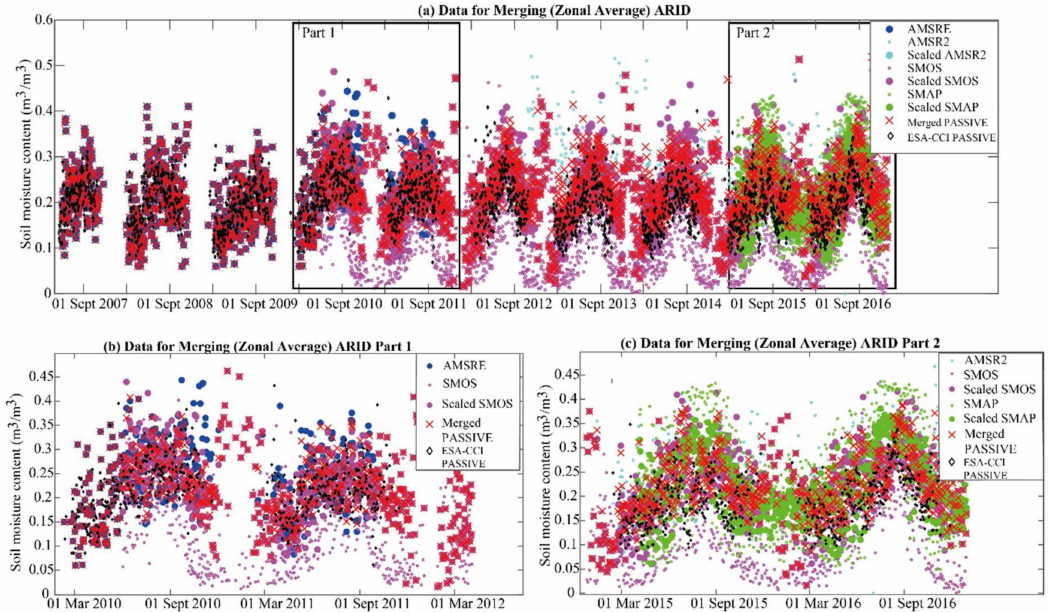
Figure 3. Time Series of Data Involved in Data Merging Procedure ( a ) Original Satellites Data, Scaled Data used for Merging, European Space Agency Climate Change Initiative (ESA-CCI) PASSIVE Data used for comparison and Merged PASSIVE SM Product (an example of the arid region) ( b ) Partial time series from 1-March-2010 to 1-March-2012; and, ( c ) Partial time-series from 1-March-2015 to